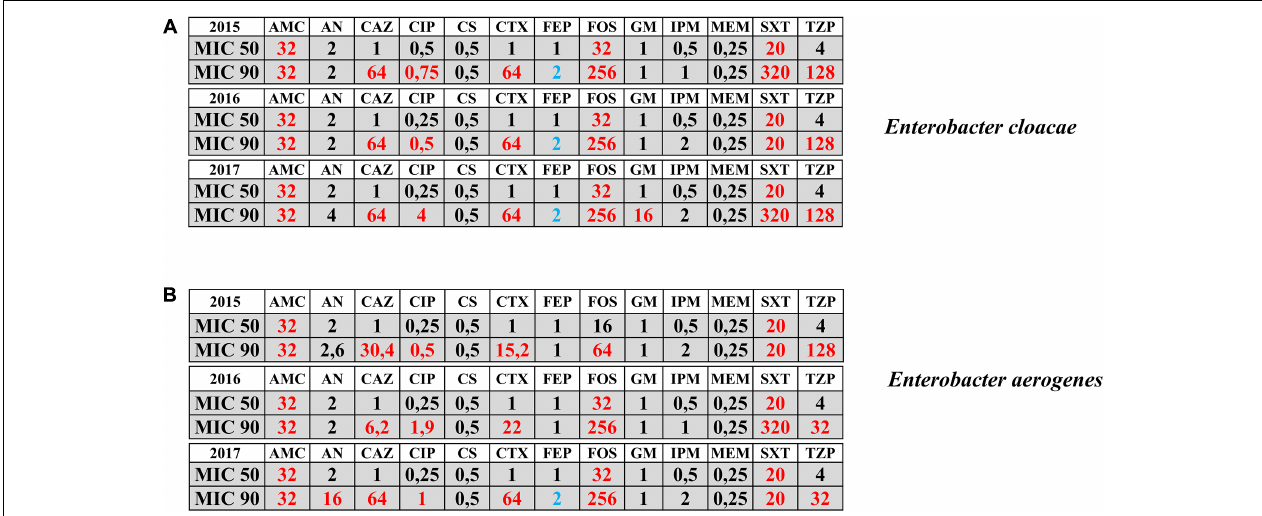
FIGURE 1 | Antimicrobial activities in terms of MIC 50 and MIC 90 registered during the years 2015–2017 for Enterobacter cloacae (panel A ) and Enterobacter aerogenes (panel B ) isolates. Sensitive MIC (black color); Resistant MIC (red color); Intermedius MIC (blue color). AMC = amoxicillin-clavulanate; AN = Amikacin;